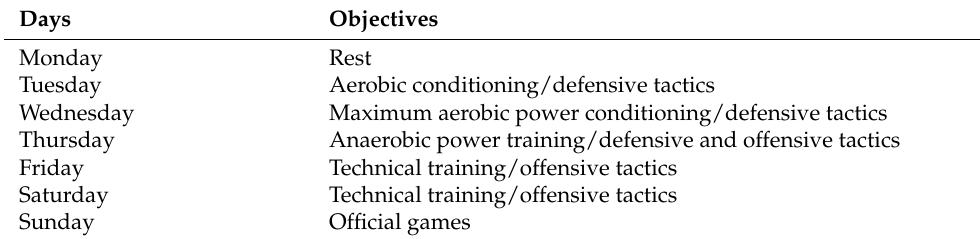
Table 1. Details of habitual training routine performed by both control and experimental groups over the 8-week